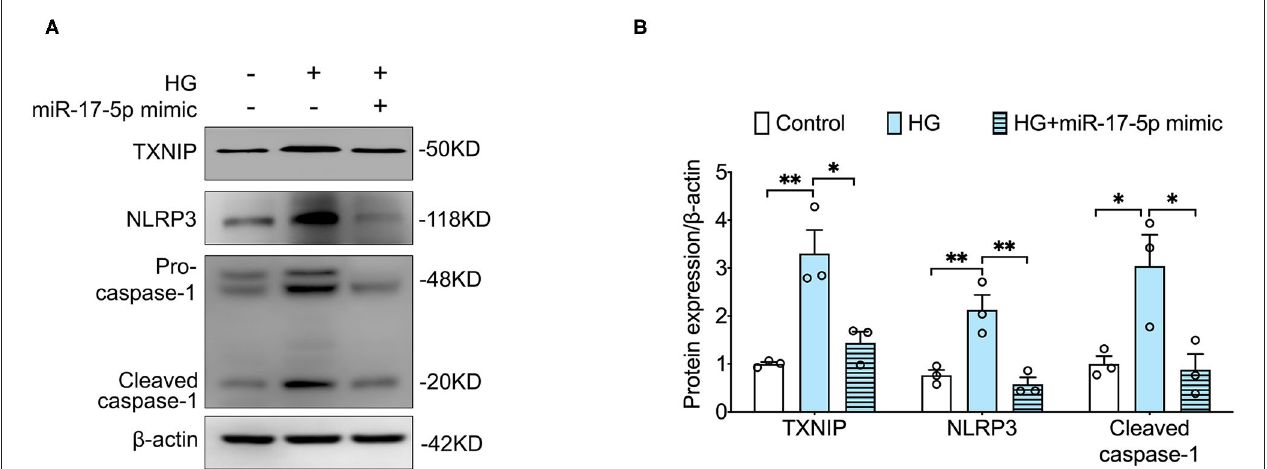
FIGURE 2 | MiR-17-5p mimic suppressed high glucose-induced hyperactivated NLRP3 inflammasome and the expression of TXNIP in INS-1 cells. (A,B) Representative blots and quantitative analysis showing the expression of NLRP3, the cleavage of caspase-1, and TXNIP. Control: 5 mmol/L; HG (high glucose): 25 mmol/L. * p < 0.05 and ** p <